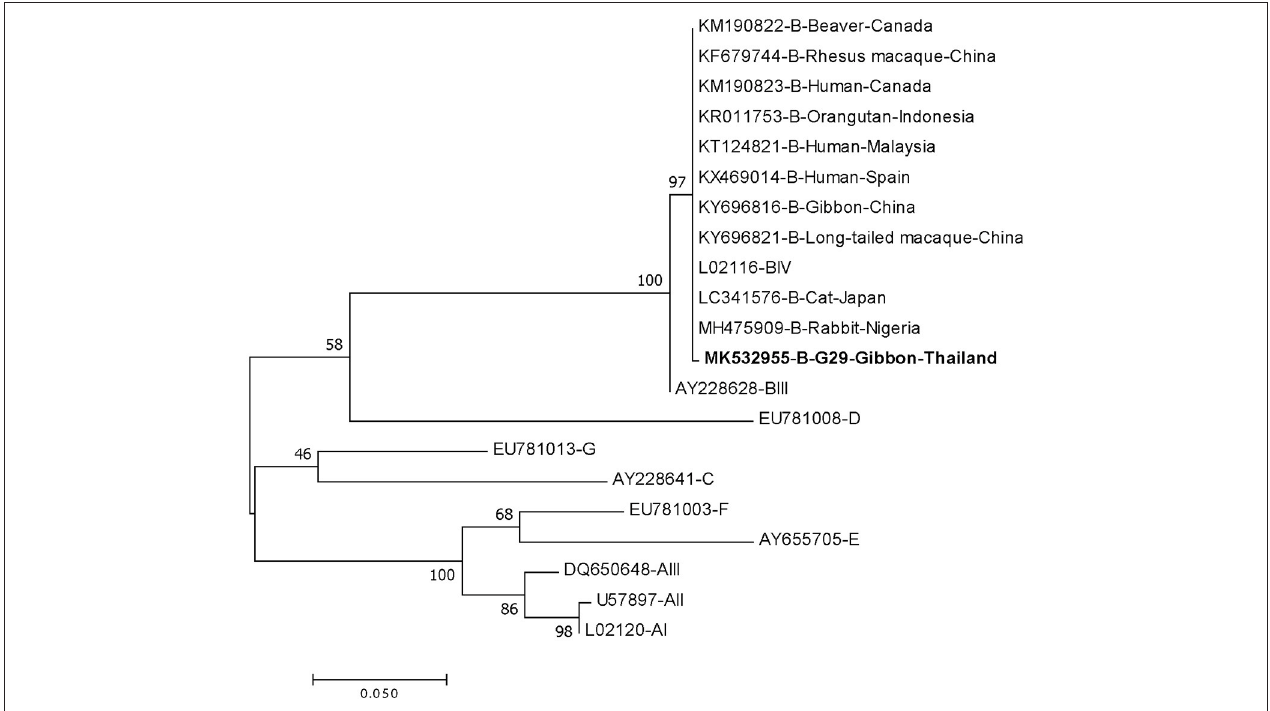
FIGURE 4 | Phylogenetic tree of Giardia isolate based on the sequence of triose phosphate isomerase (tpi) gene from a gibbon in this study by the Maximum Likelihood algorithm using the MEGA 6.06 program. Sequences obtained from GenBank are indicated by their accession numbers. Percentage bootstrap supports (500 replicates) are shown by numbers at the respective nodes. Bold texts represent the Giardia detected in this